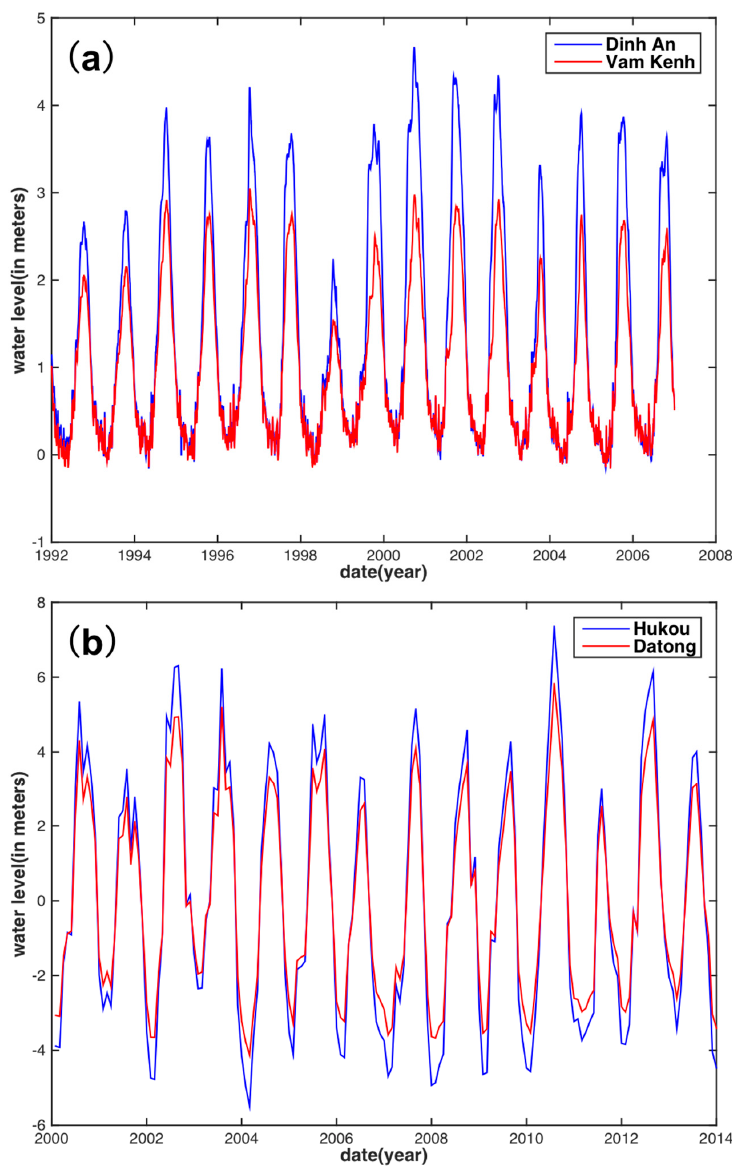
Figure 2. ( a ) Time series of water level at Dinh An (blue) station and Vam Kenh (red) station in the Mekong River Basin (MRB); ( b ) Time series of water level in Hukou (blue) station and Datong (red) station in the Yangtze River Basin (YRB).